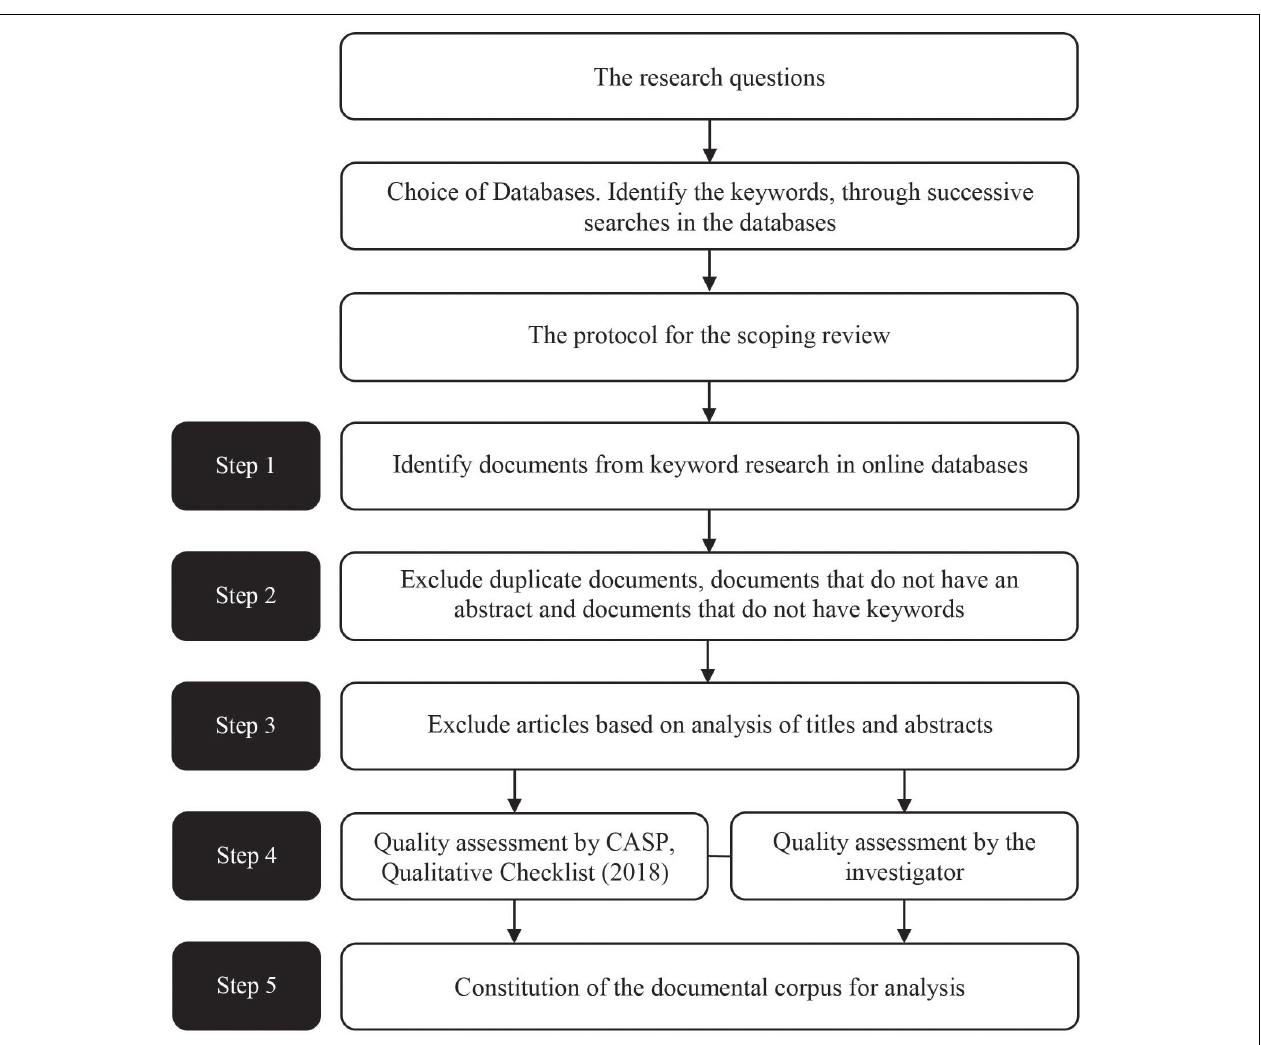
FIGURE 1 | Organizational structure of the SR. Authors’ own